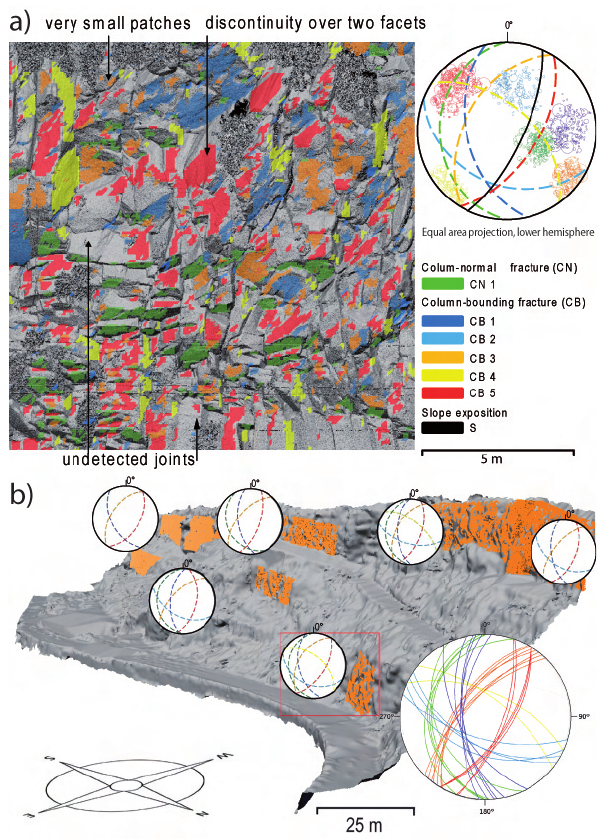
Fig. 7. Software aided semi-automated discontinuity analysis: small patches, discontinuities over several facets and undetected joints conditioned visual verification (a) . Displaying orientation data in lower hemisphere stereographic projections at each point of interest resulted in a discontinuity characterization of the overall slope (b) .